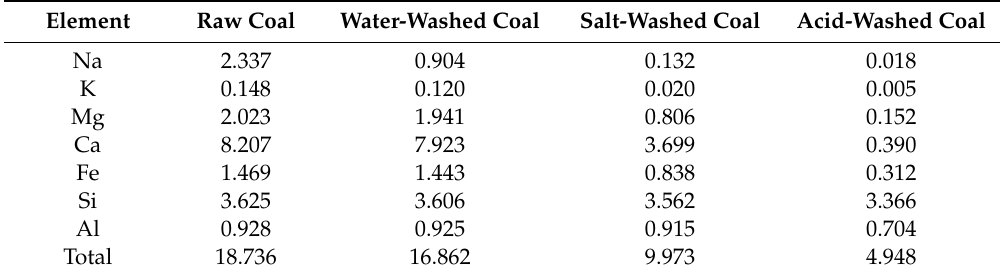
Table 3. Contents of main mineral elements in the coal samples (mg /